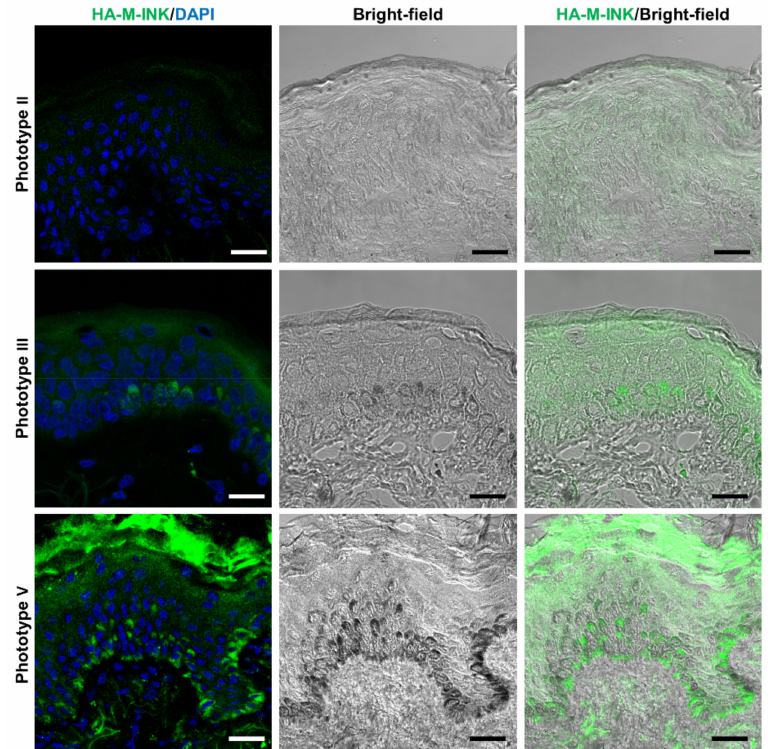
Figure 5. Immunostaining images of HA-M-INK and melanin content in the skin from di ff erent skin phototypes. Skin sections of phototypes II (top), III (middle), and V (bottom) were stained for HA-M-INK (green) and DAPI (blue). Phototype II: The sample was mostly negative for HA-M-INK. Phototype III: Melanin was observed as a melanin cap in the spinous layer and in the basal layer, and was colocalized with HA-M-INK. Phototype V: Melanin was observed as a melanin cap, which was widely distributed across the basal and spinous layers, and HA-M-INK-positive signals were well colocalized with the melanin. Scale bars = 20 µ